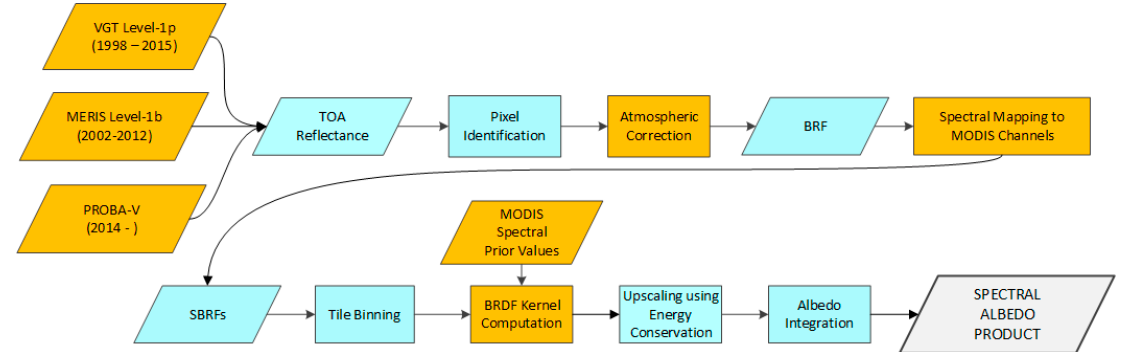
Figure 5 . QA4ECV spectral albedo product top-level traceability chain. VEGETATION; MERIS: medium-resolution imaging spectrometer; PROBA-V: PROBA vegetation sensor; TOA; top of atmosphere; and SBRFs: surface bidirectional reflectance